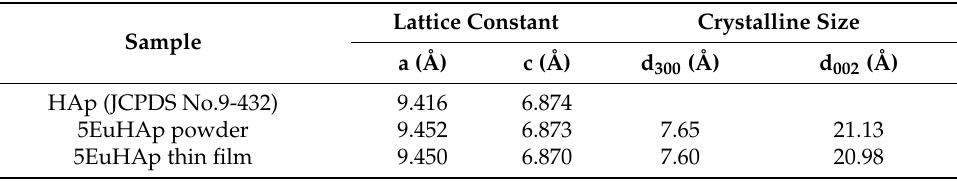
Table 1. Lattice constant and crystalline sizes calculated from the XRD patterns of the